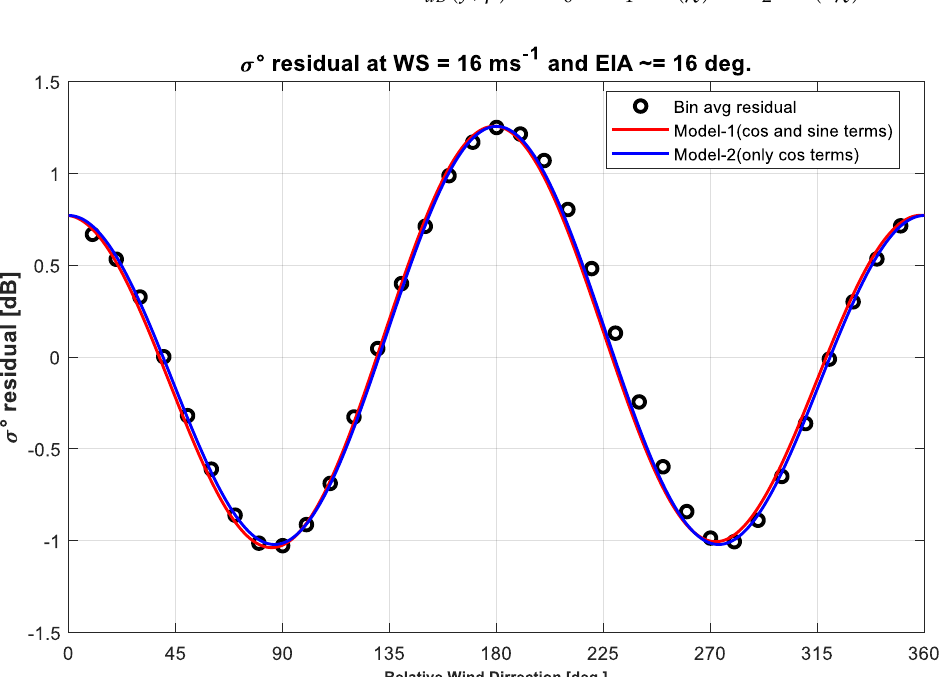
Figure 3. Effect of odd and even terms (in dB) in the ocean σ 0 backscatter model at low earth incidence angles (EIAs).